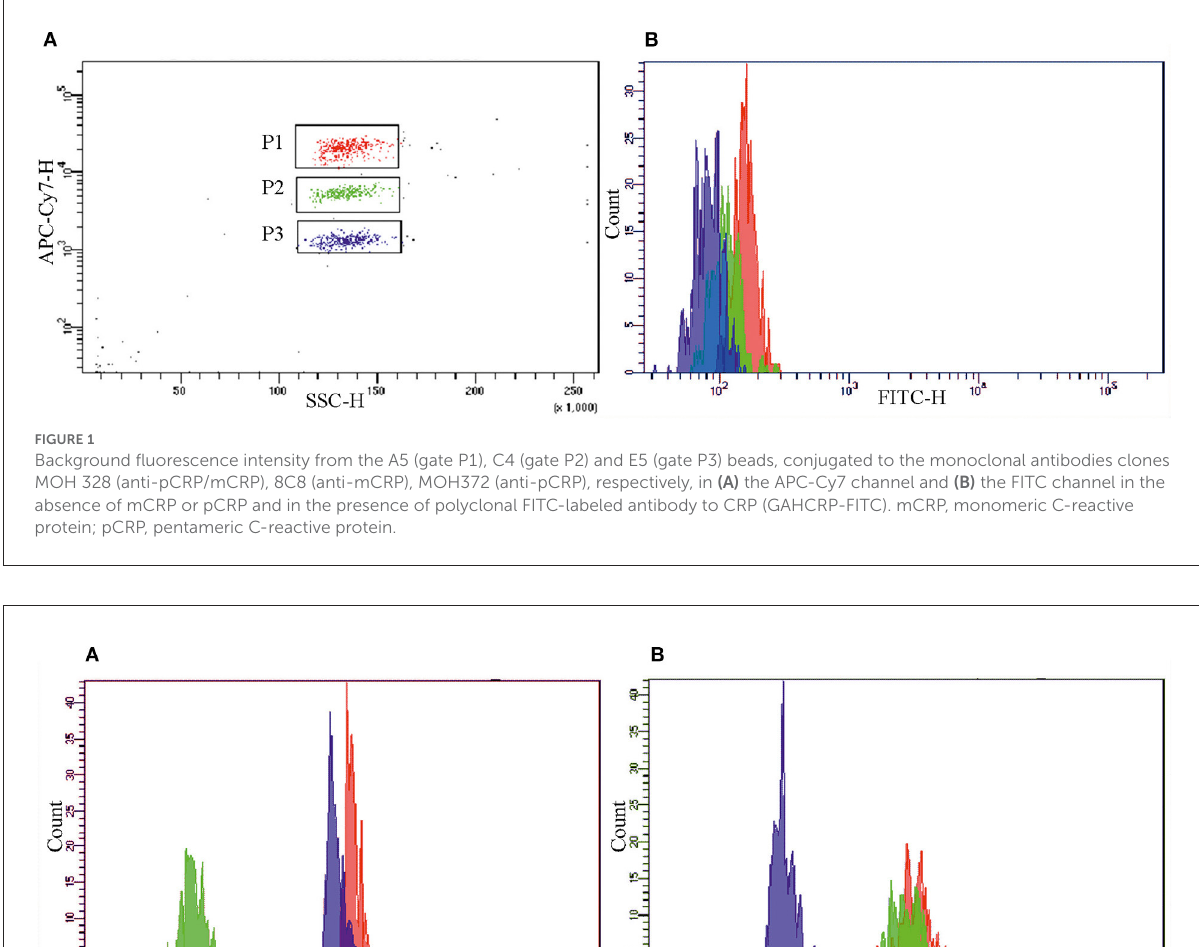
within the range from 1.0 to 100.0 µ g/L. From this concentration the actual mCRP level can be calculated considering the sample dilution